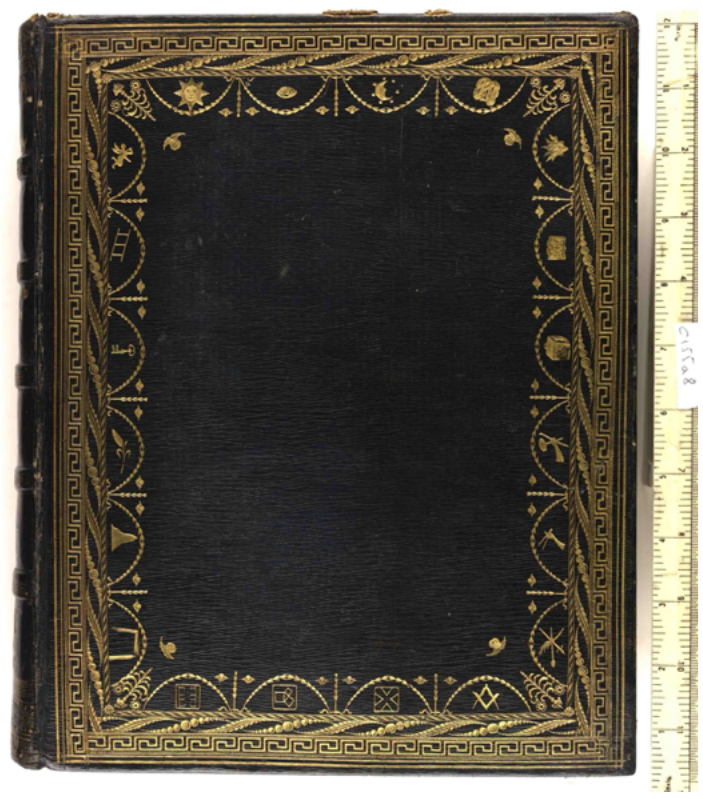
Fig. 16. Binding on Holy Bible (Oxford, 1808) by John Lovejoy. British Library, C.155.a.8. Henry Walther (c.